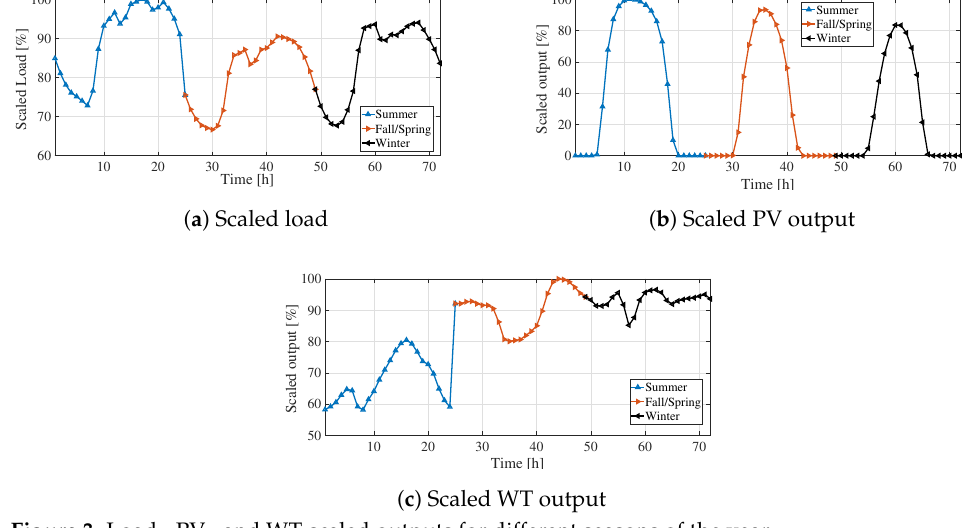
Figure 3. Load-, PV-, and WT-scaled outputs for different seasons of the year.